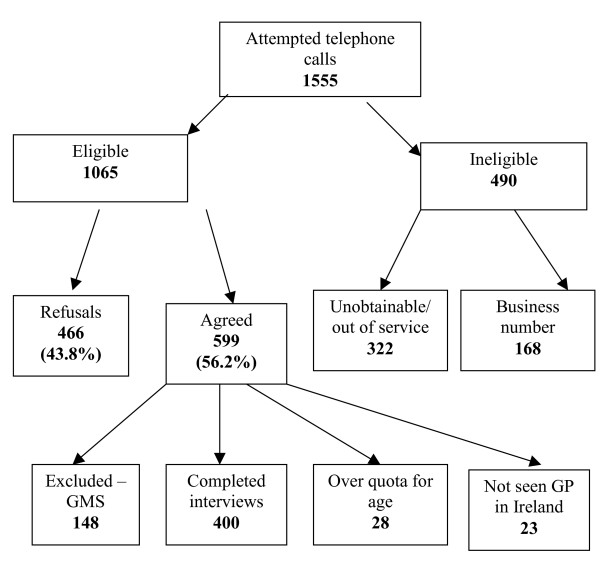
Conduct of telephone survey.